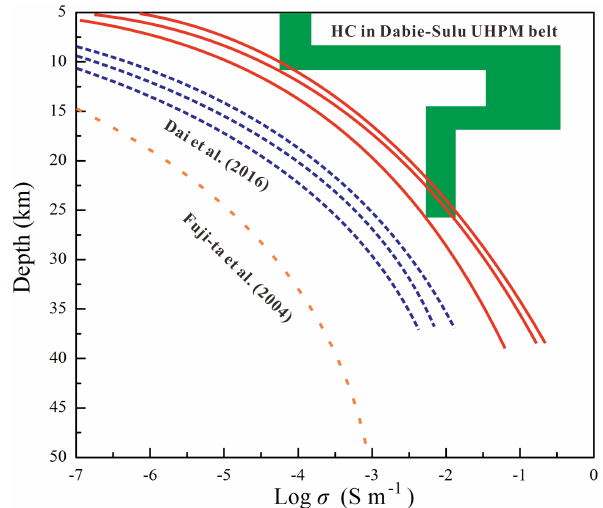
Figure 10. Laboratory-based conductivity–depth profiles con- structed from data of the gneiss samples and the thermodynamic parameters; comparison with geophysically inferred field results from the Dabie–Sulu UHPM belt, China. The red solid lines rep- resent the conductivity–depth profiles based on the conductivities of the samples described in Fig. 3 and based on a surface heat flow of 75mWm − 2 in the Dabie–Sulu UHPM belt. The dashed blue lines represent the conductivity–depth profiles based on the conductivities of eclogite, and the dashed brown line represents the conductivity–depth profiles based on the conductivities of gran- ulite (Fuji-ta et al., 2004; Dai et al., 2016). The green region repre- sents the MT data derived from a high conductivity anomaly in the Dabie–Sulu UHPM belt (Xiao et al., 2007; He et al.,